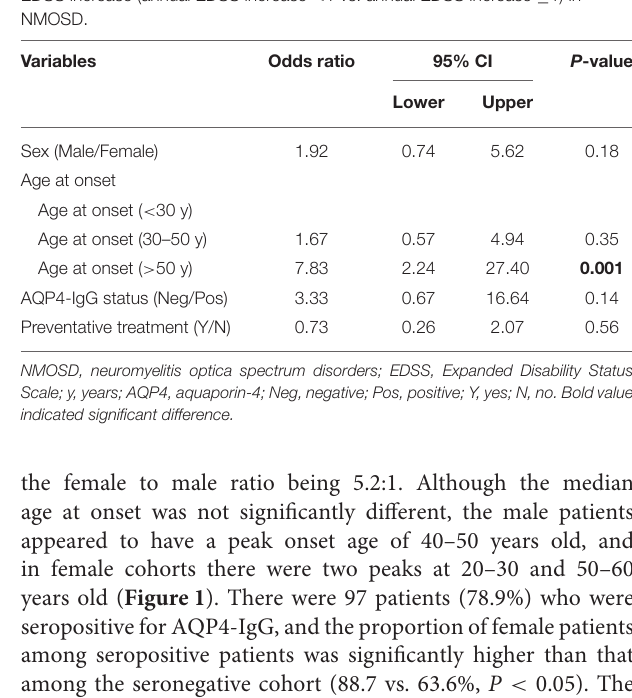
TABLE 3 | Binary logistic regression analysis of factors associated with annual EDSS increase (annual EDSS increase < 1 vs. annual EDSS increase ≥ 1)